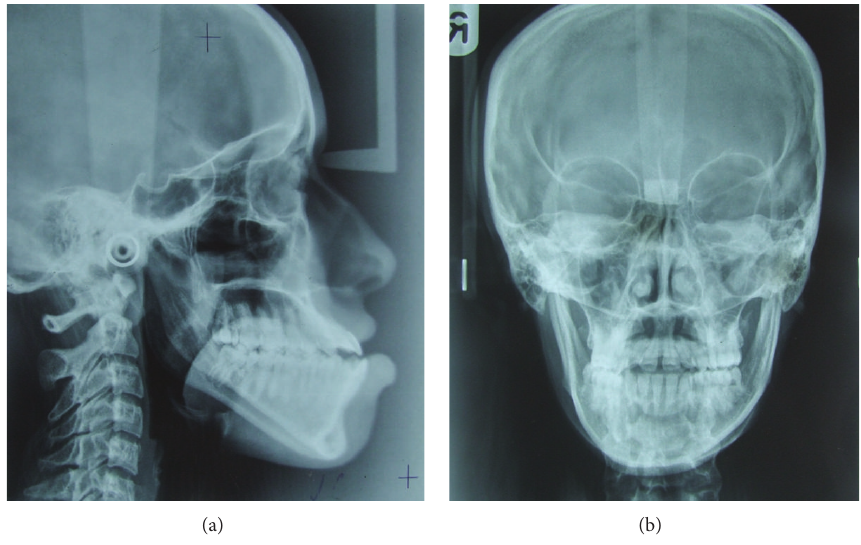
Figure 5: Pretreatment: (a) lateral, and (b) PA cephalograms.